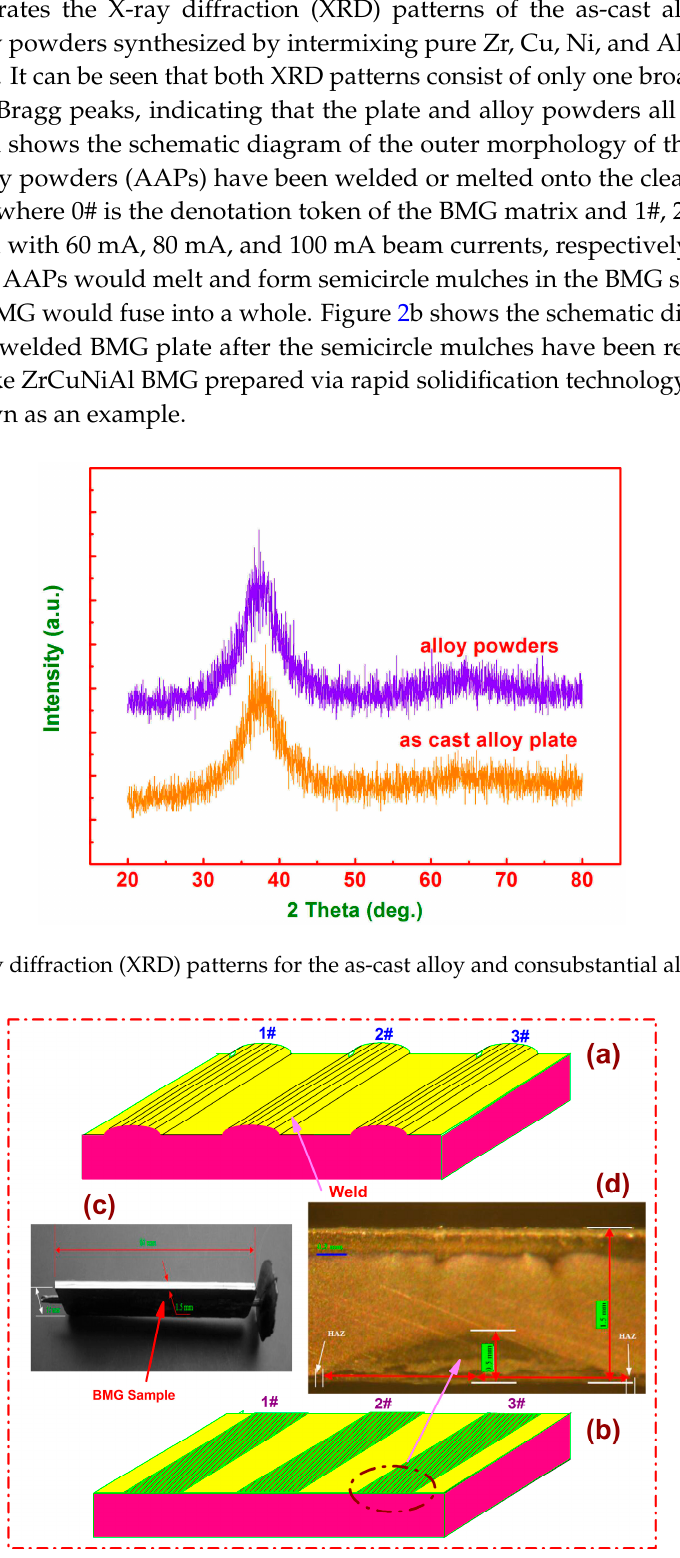
Figure 2. Schematic diagrams of the welded bulk metallic glass (BMG) plate ( a ) before and ( b ) after the semicircle mulches have been removed; ( c ) the as ‐ cast plate ‐ like BMG sample; and ( d ) a weld.